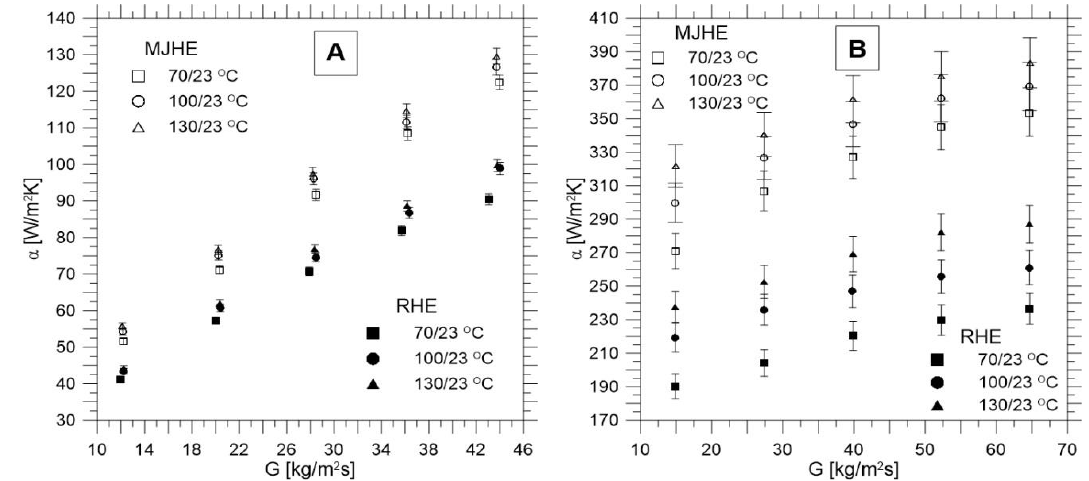
Figure 4. Heat transfer coe ffi cients versus the mass flow density: ( A )—heating side (air), ( B )—heated side (water).